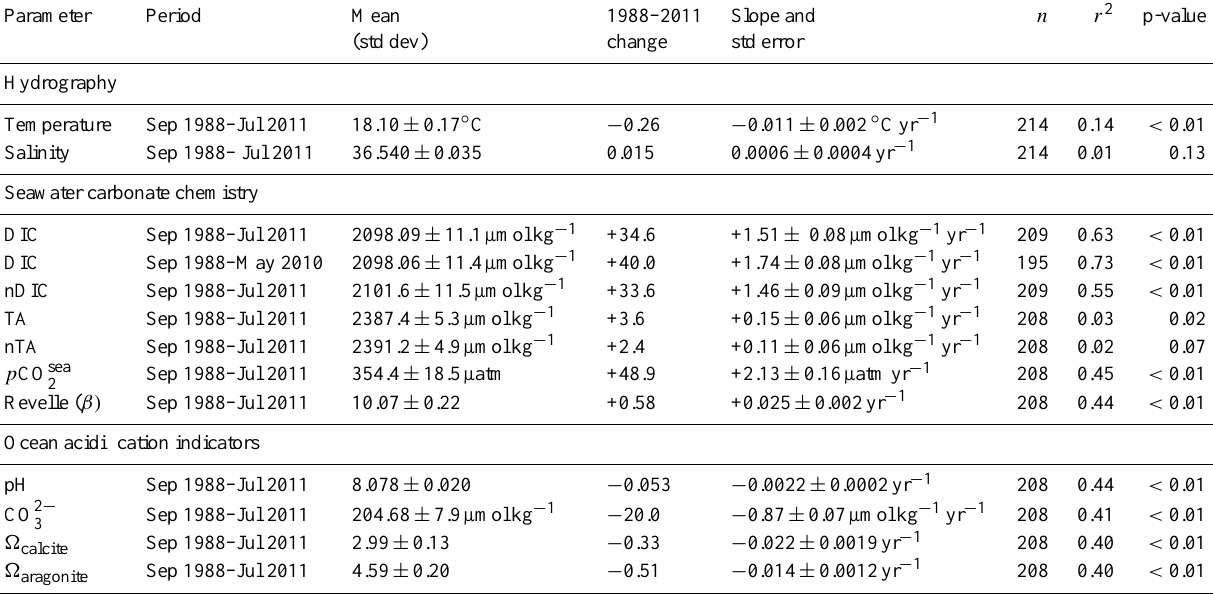
Table 1. Long-term trends (1988–2011) of STMW hydrography and seawater carbonate chemistry with regression statistics (slope and error, n , r 2 and p-value). This table includes trend analyses of STMW including temperature, salinity, seawater carbonate chemistry (i.e. DIC, ) , calculated seawater p CO 2 ( p CO sea ) and Revelle factor ( β) anomalies), and indicators of nDIC, TA, nTA, atmospheric p CO 2 ( p CO atm 2 2 seawater carbonate chemistry changes (i.e. pH, [CO 2 − ], and mineral saturation states of calcite ( (cid:127) calcite ) and aragonite ( (cid:127) aragonite ) ) from 3